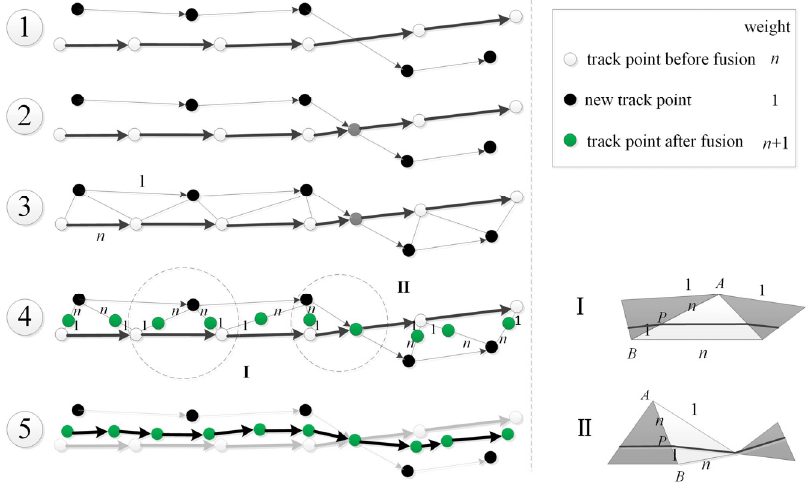
Figure 3. Constrained Delaunay triangulation and merging of two similar traces.